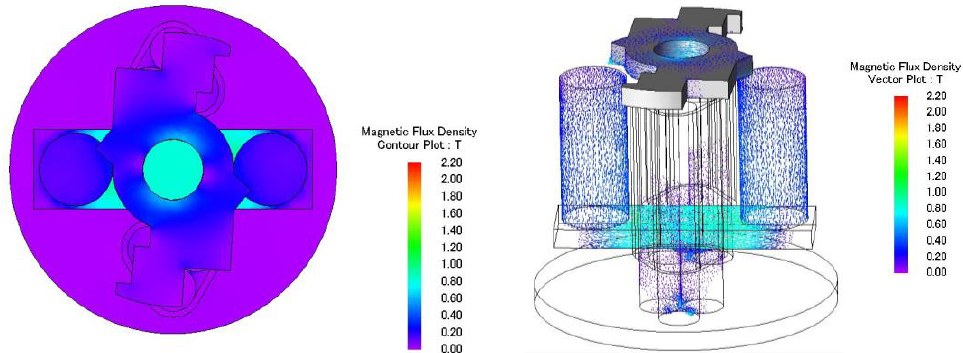
Figure 13. Top view and 3D view of magnetic flux density plots of the motor at a rotating angle of 91°.